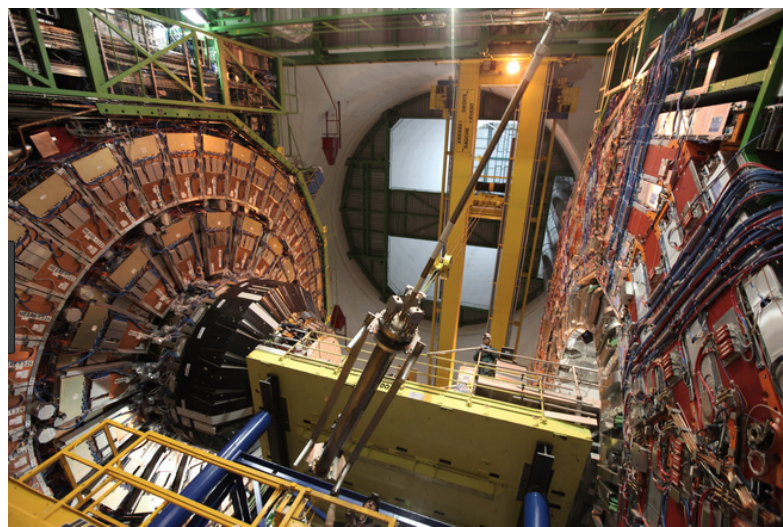
Figure 11. A photograph of the CMS beam-pipe being